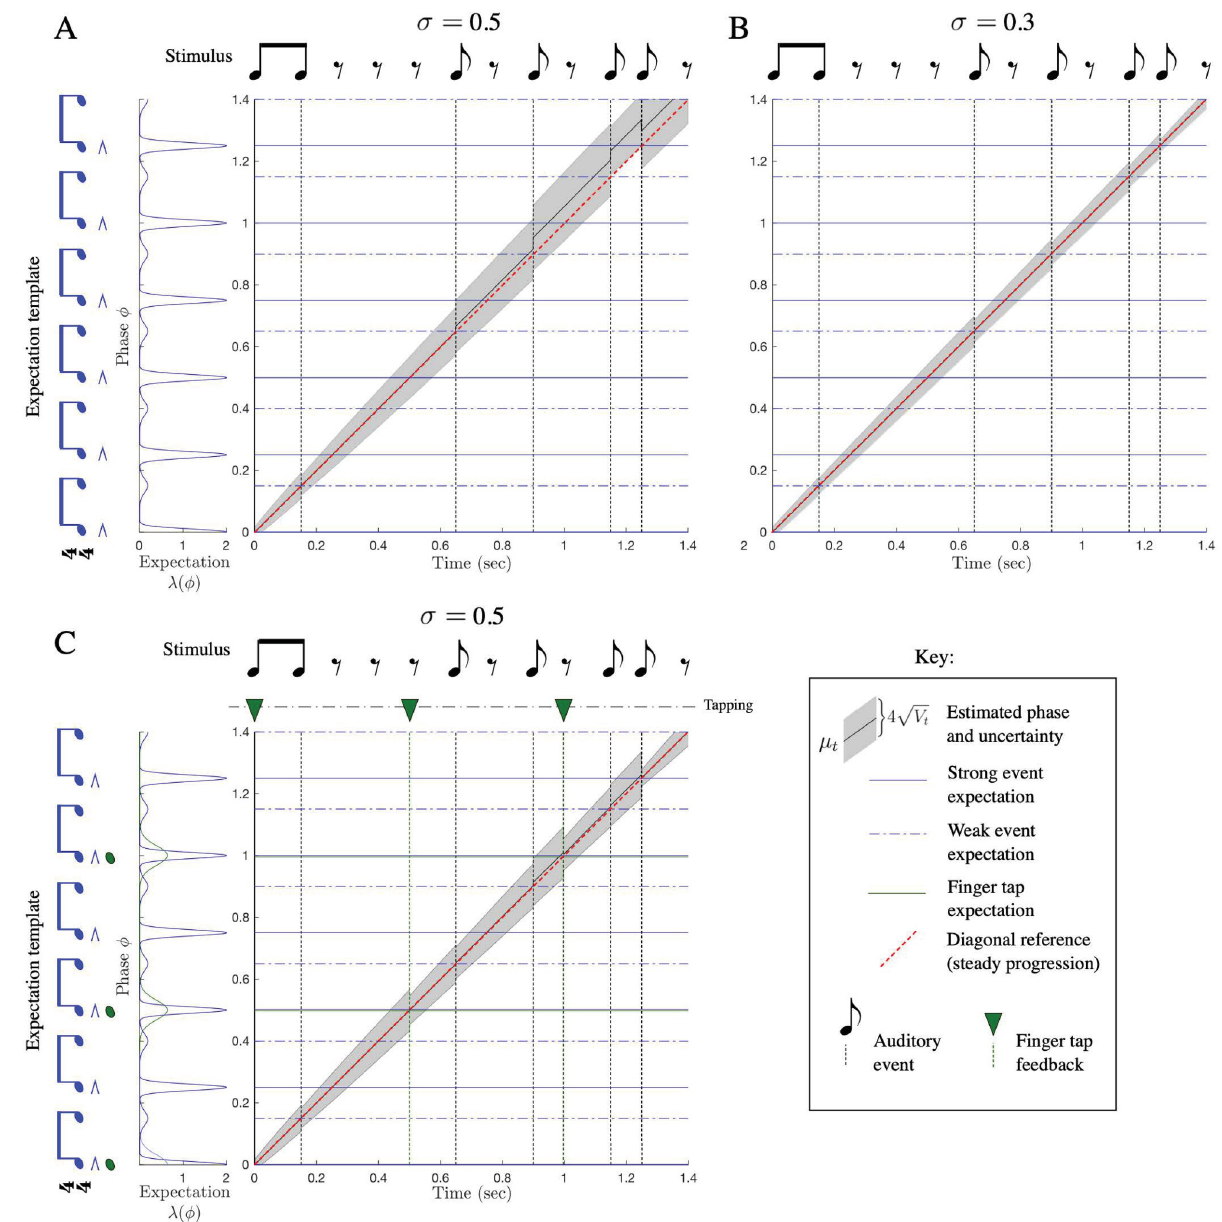
Fig 4. Too much syncopation causes rhythm tracking failure. A predominance of events associated with weak expectations combined with accumulated phase uncertainty can lead to a failure to track phase accurately. A) In this example, phase uncertainty V increases over a long silence. At the next event, this high uncertainty leads the model to partially attribute a weakly expected event to the nearby phase at which an event is strongly expected. As a result, the model ends up aligning the fifth event with a strong phase rather than a weak one, and overestimating phase at the final event (correct phase marked with yellow dot). B) When the rate of accumulation of phase uncertainty (i.e., the expected phase noise σ 2 ) is decreased, phase is tracked correctly. C) Alternatively, phase can be tracked successfully by inserting an isochronous stream of finger taps and a suitable template for the alignment between expected auditory feedback from the taps and phase. We use mPIPPET to simulate an expectation for isochronous taps (green notes and trace on the left). For simplicity, taps are placed every 0.5 sec; however, even noisy taps generated based on estimated phase could serve to reduce phase uncertainty and avoid a total phase tracking